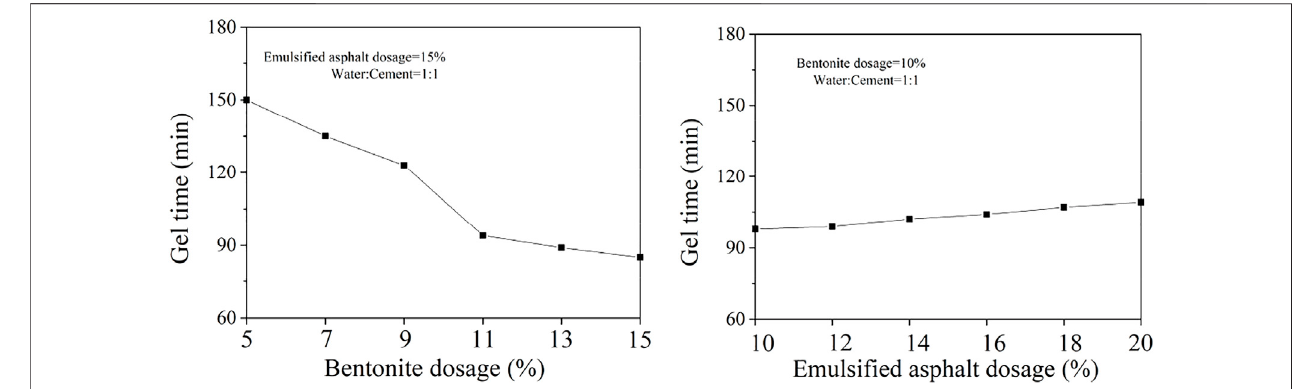
FIGURE 2 | In fl uence of bentonite dose and emulsi fi ed asphalt dose on the gel time of CACG.